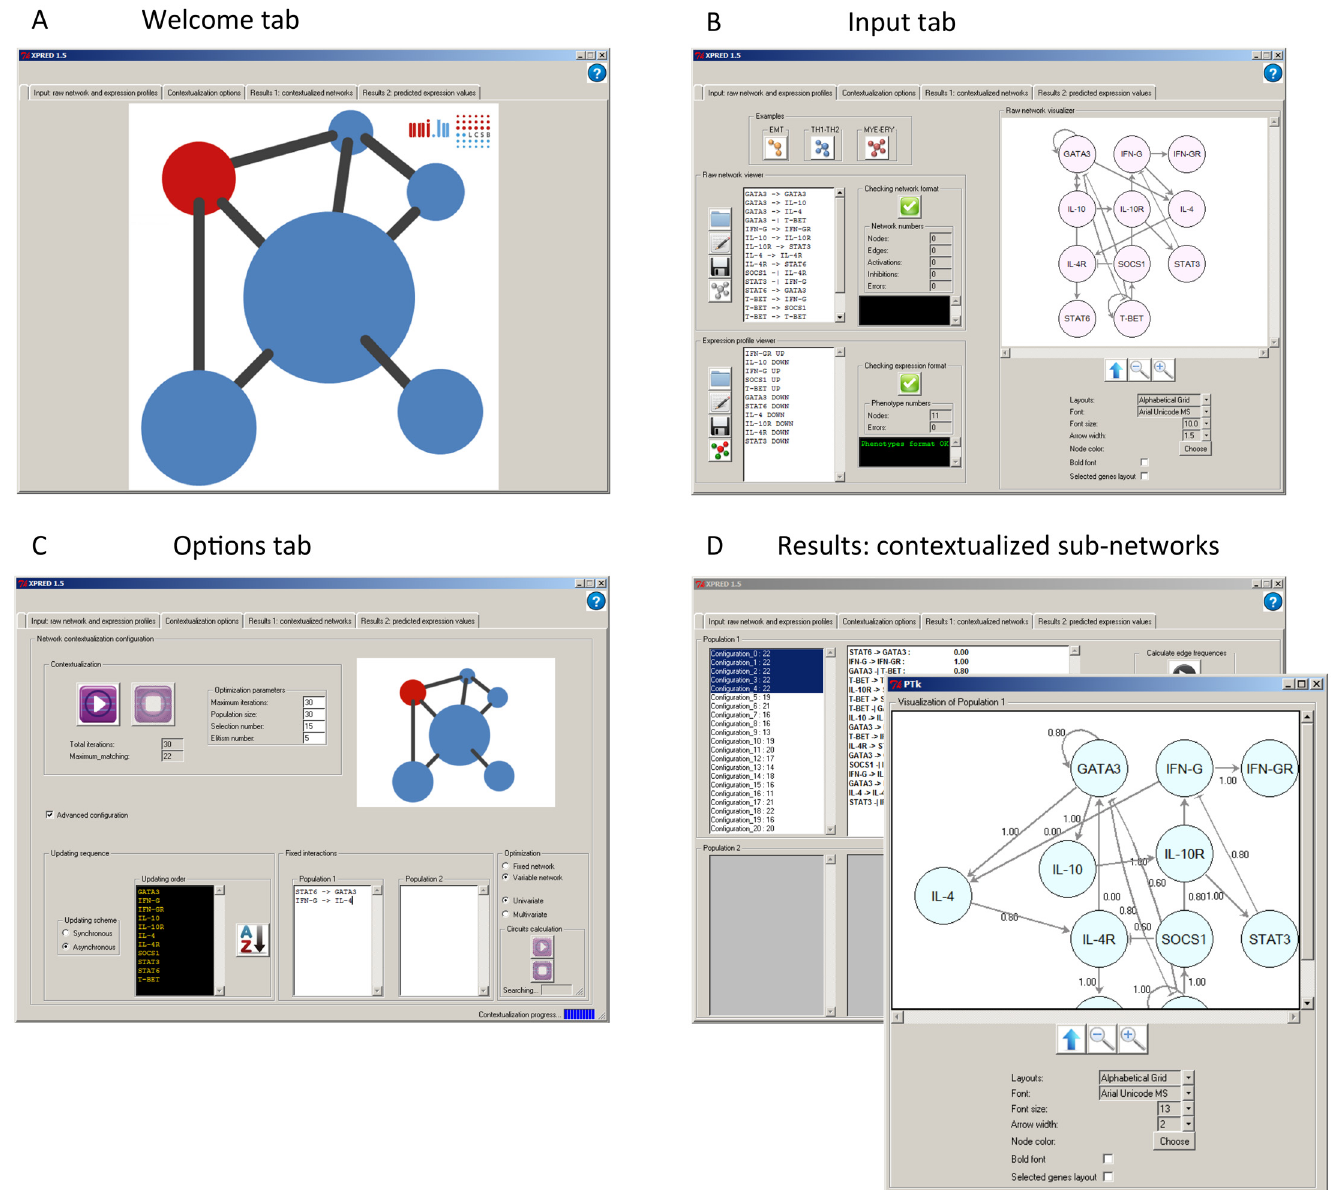
Fig 2. PRUNET interface. The graphical user interface is organized in tabs, namely a welcome tab ( A ), input tab ( B ), options tab ( C ) and results tab (D). Both the input and results tab include a network visualizer to facilitate the interaction of the user with the